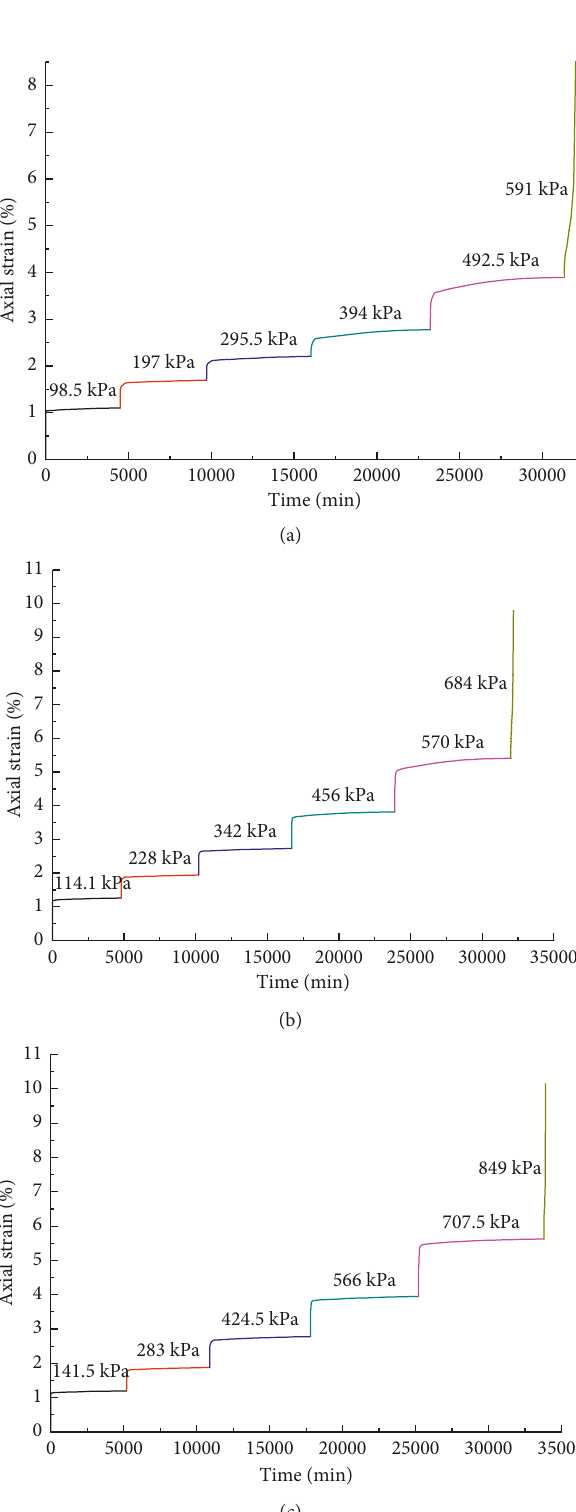
Figure 2: Relation between creep strain and time under different confining pressures: (a) 100kPa, (b) 150 kPa, and (c) 200